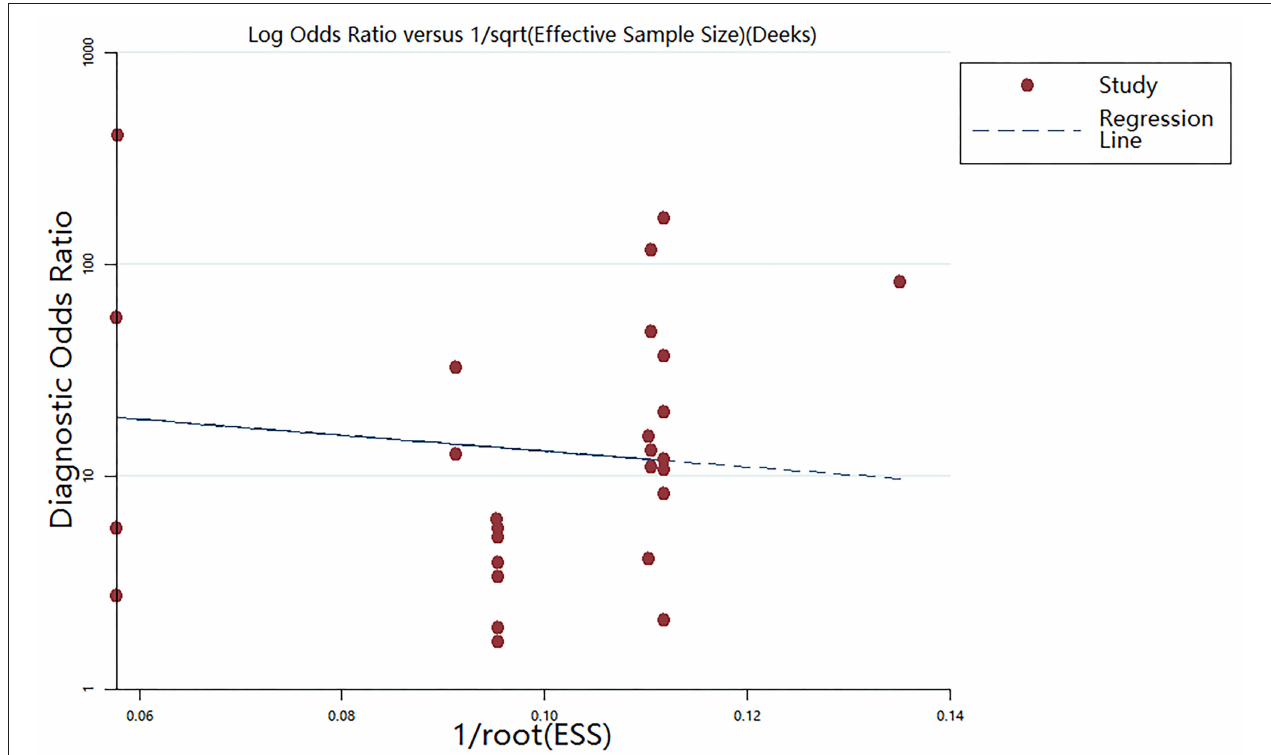
FIGURE 5 | The Deeks’ funnel plot asymmetry test ( P =